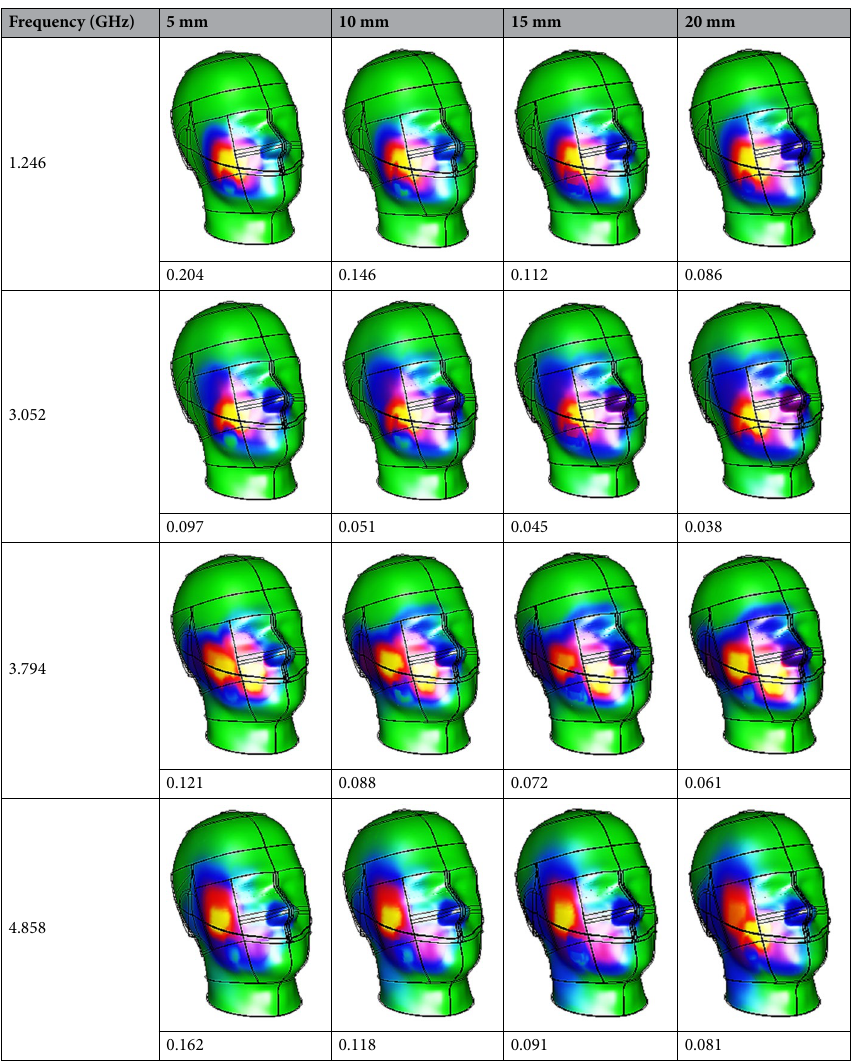
Table 12. SAR values of 10 g of tissue volume for various mobile phone distance from human head.